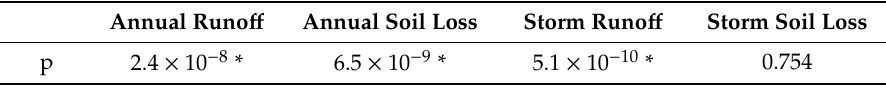
Table 10. Results of Mann-Whitney U-test, testing di ff erences between undisturbed and disturbed samples.